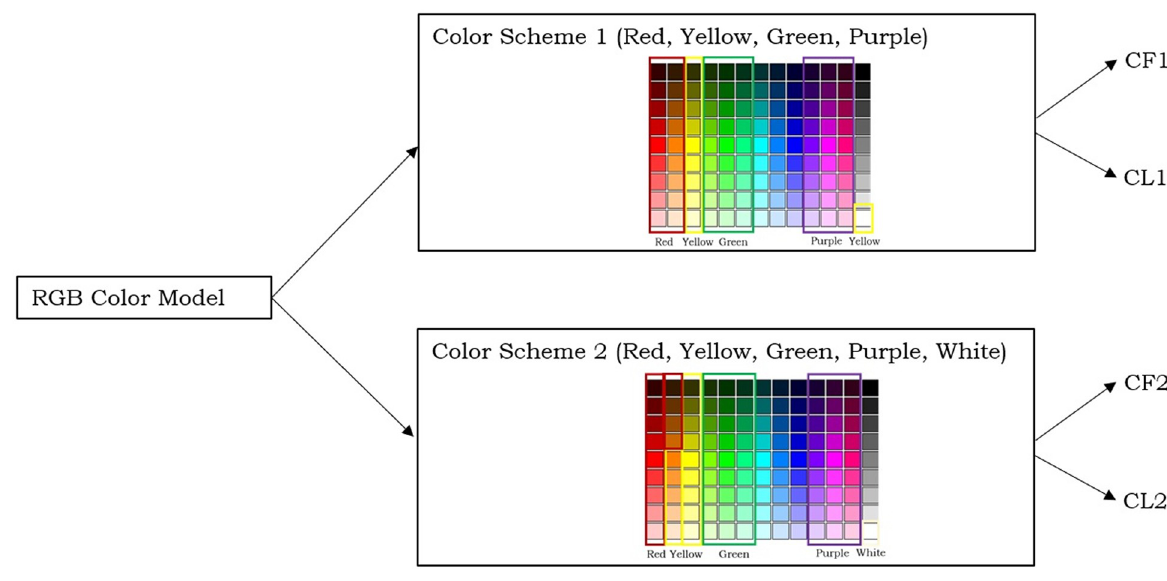
Fig 3. Color scheme